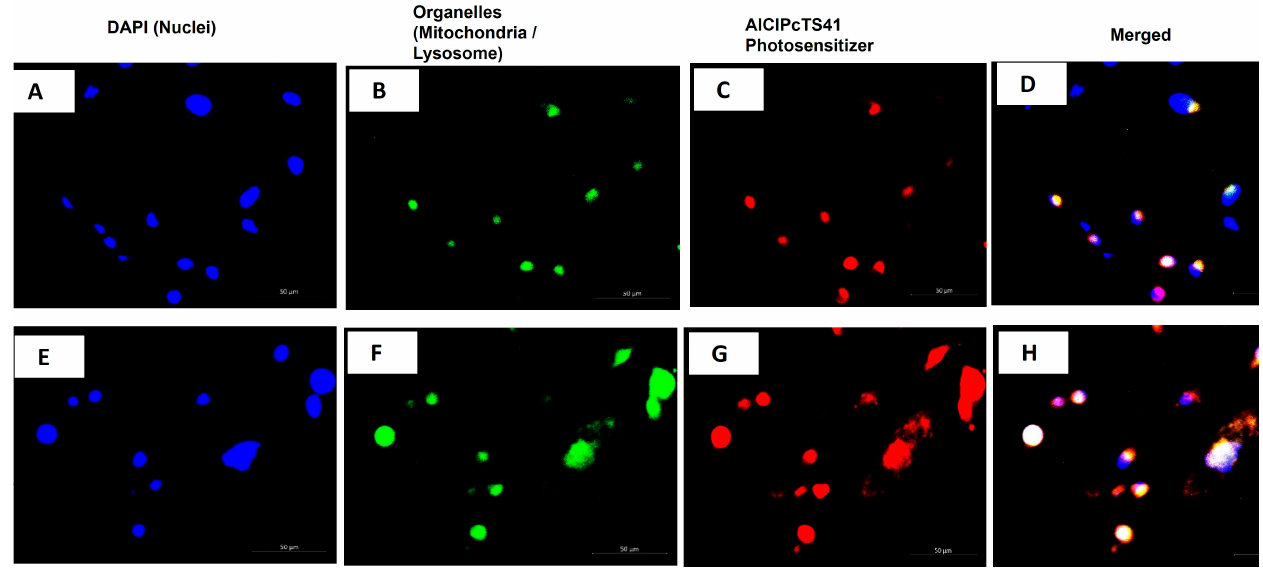
Figure 10. Assessment of AlClPcTS41-PEG-CuAuNPs subcellular localization via fluorescence microscopy in Caco-2 cells, whereby Caco-2 cells were stained with LysoTracker and MitoTracker green, respectively: ( A , E ) nuclei stained blue with DAPI; ( B , F ) Mitotracker fluorescence green, and Lysotracker fluorescence green, respectively; ( C , G ) AlClPcTS41-PEG-CuAuNPs red fluorescence and ( D , H ) localization of AlClPcTS41-PEG-CuAuNPs and Mitotracker or Lysotracker showed a yellow colour from the green and red merge, demonstrating localization in both the mitochondria and the lysosomes. (Scale bar: 50 µm).